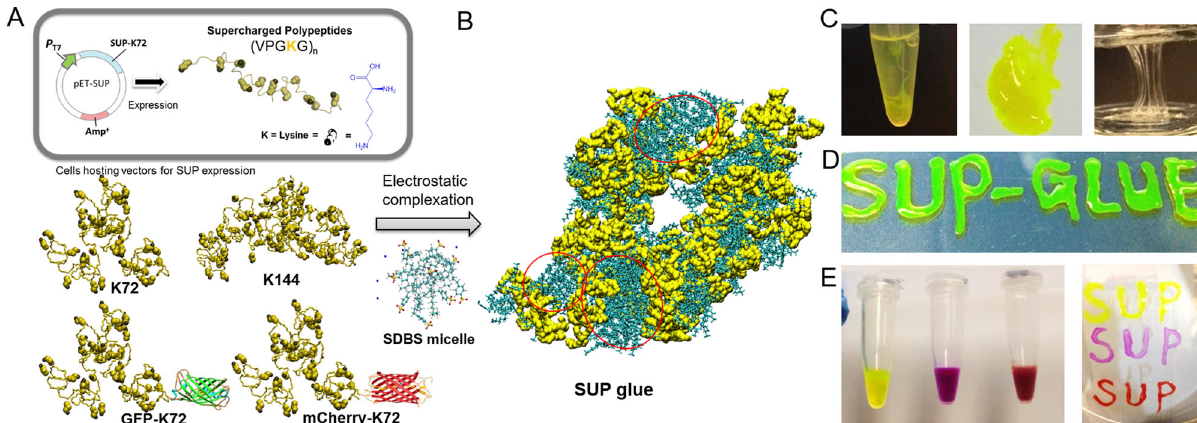
Fig. 1 Fabrication and investigation of the SUP-SDBS glue system. A Schematic illustration of cationic supercharged polypeptide (SUP) expression through genetically engineered E. coli . The polypeptide backbones are shown in a random coil conformation. Lysine is presented in a space- fi lling model in yellow and the charged amino-group in gray. A series of SUPs with different chain lengths (K18, K36, K72, K108, and K144) and SUP fusions with GFP and mCherry were produced. B The glue was prepared via electrostatic complexation of SUP and SDBS micelles. An all-atomistic simulated K18-SDBS complex is shown. In this model, K18 is shown in yellow, SDBS in cyan, and some of SDBS micelle domains are encircled in red. C For the fabrication, a solution of SUP (here GFP-K72) was mixed with a solution of SDBS micelles leading to liquid-liquid phase separation and the formation of a coacervate. After centrifugation, the supernatant was removed (left) and the coacervate consisting of SUP-SDBS complex was collected by a pipette and applied to a glass surface (middle and right). D Fluorescent SUP glues show robust adhesion behavior when applied on glass surfaces and are deformable. E GFP-SUP, mCherry-SUP, and a mixture of both with different emission colors were used to prepare